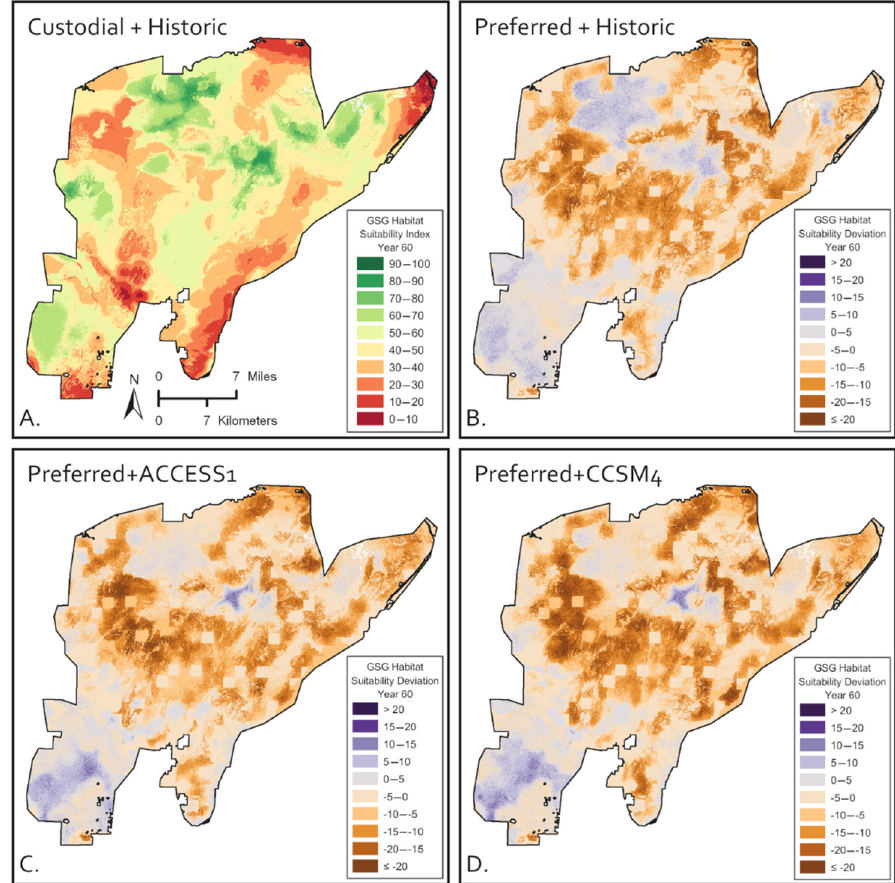
Figure 9. Habitat suitability for GSG in the Black Mountains at year 60 for the C USTODIAL + H ISTORIC scenario ( A ), and absolute deviations from that standard for the P REFERRED + H ISTORIC ( B ), P REFERRED + ACCCES1 ( C ), and P REFERRED + CCSM4 ( D ) scenarios, based on 2013 five-meter RapidEye satellite imagery.